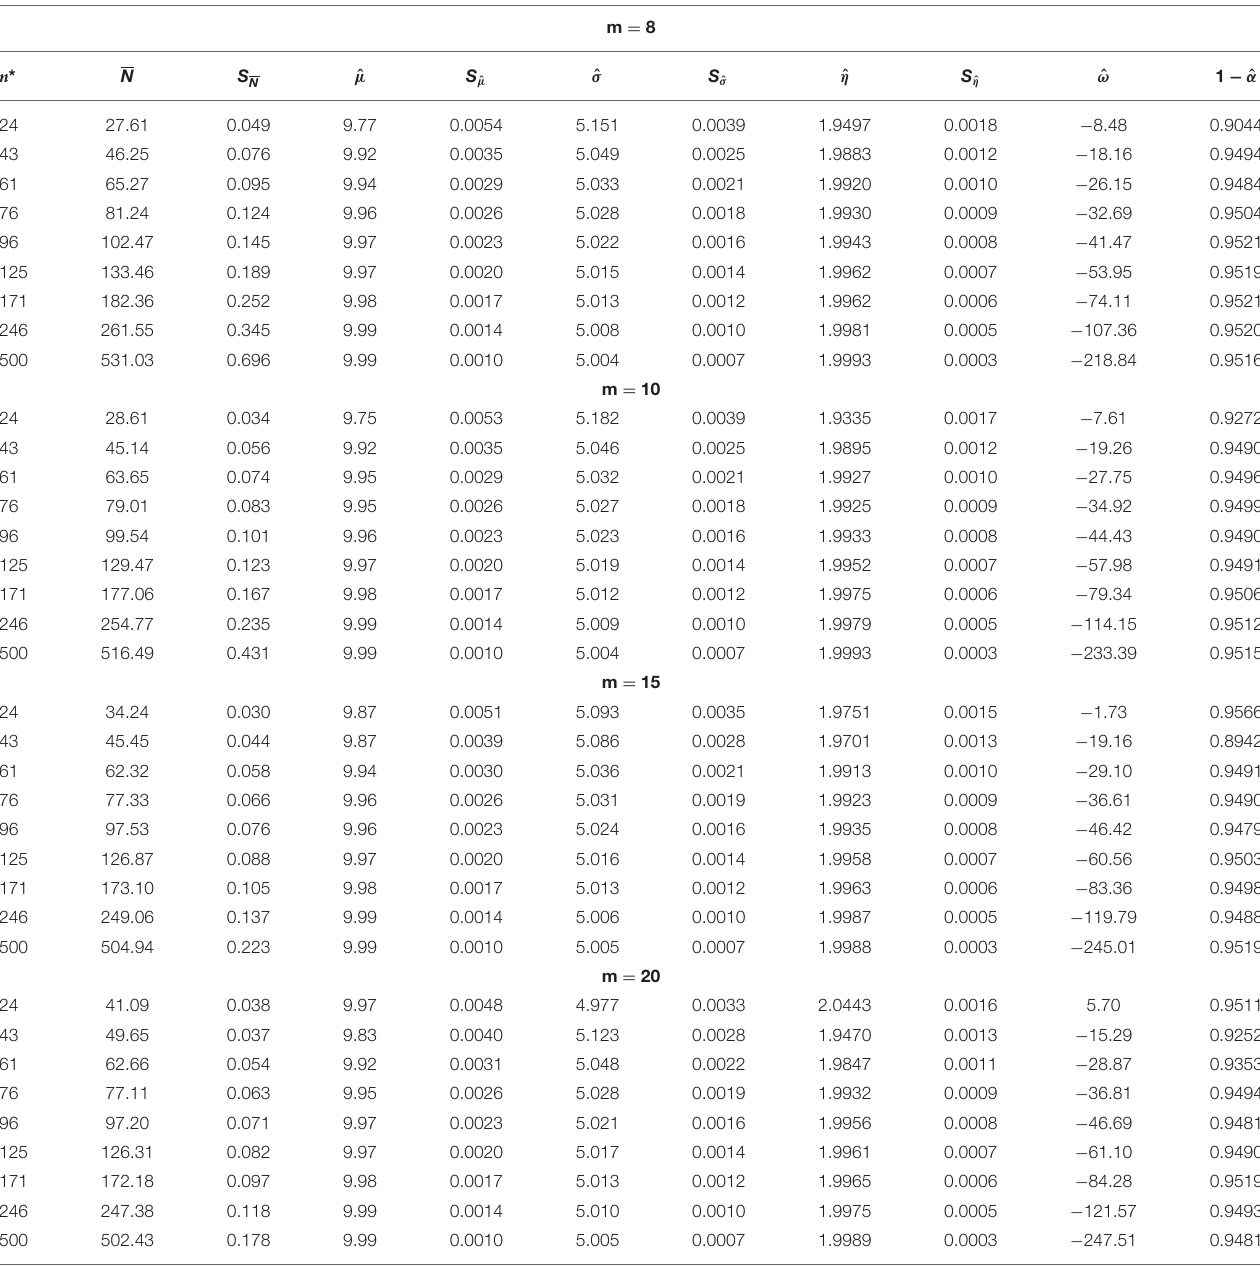
TABLE 2 | The impact of increasing the pilot sample m on the procedure at µ